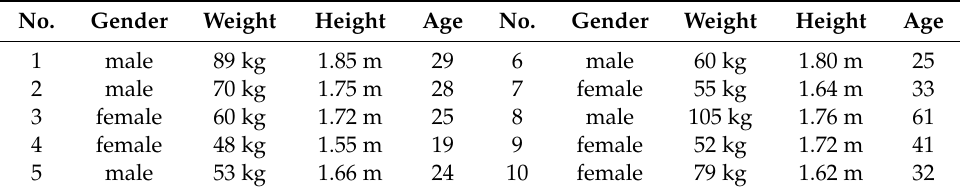
Table 3. Subjects information in collecting gait data.